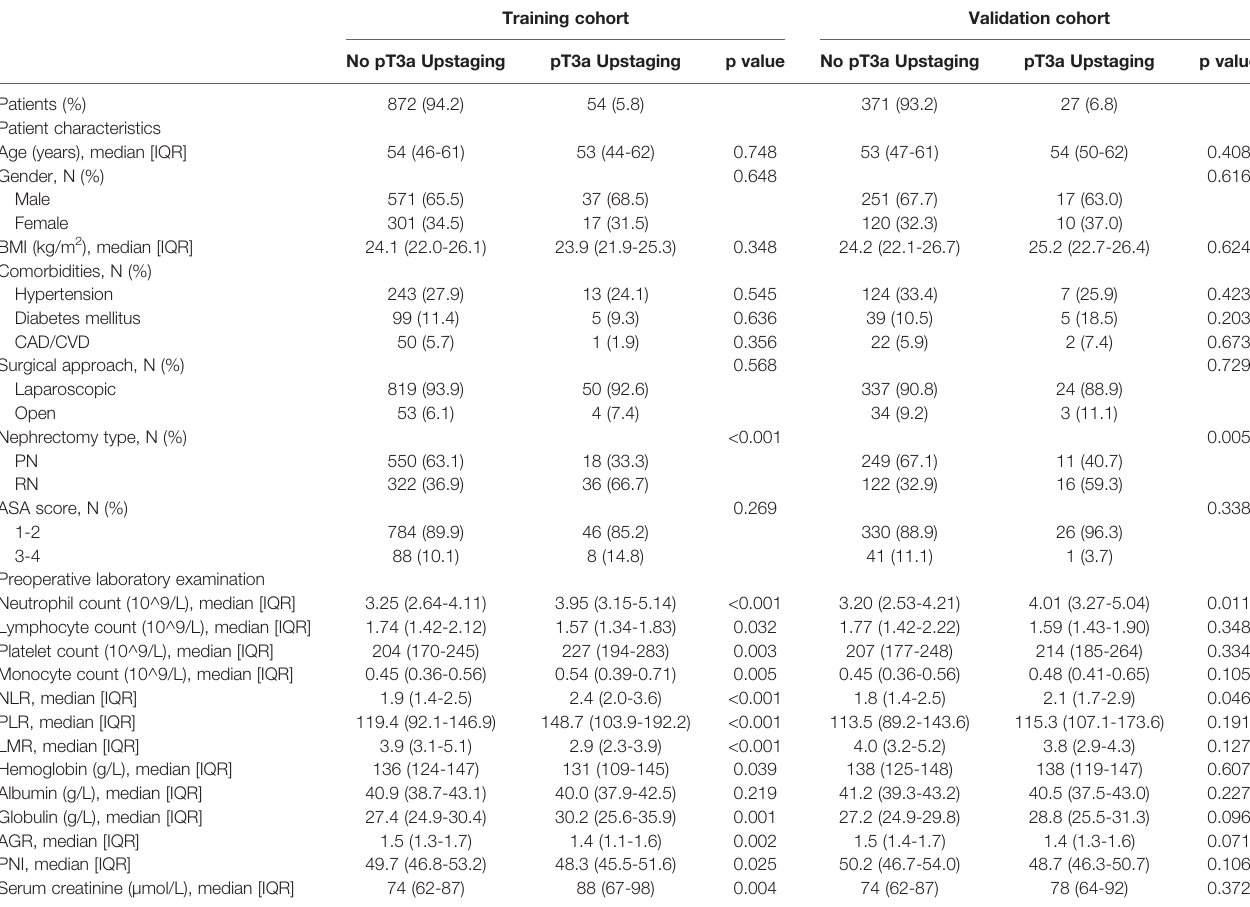
AGR,albumintoglobulinratio;ASA,AmericanSocietyofAnesthesia;BMI,bodymassindex;CAD,coronaryarterialdisease;CVD,cerebrovasculardisease;IQR,interquartilerange;LMR, lymphocyte to monocyte ratio; NLR, neutrophil to lymphocyte ratio; PLR, platelet to lymphocyte ratio; PN, partial nephrectomy; PNI, prognostic nutrition index; RN, radical